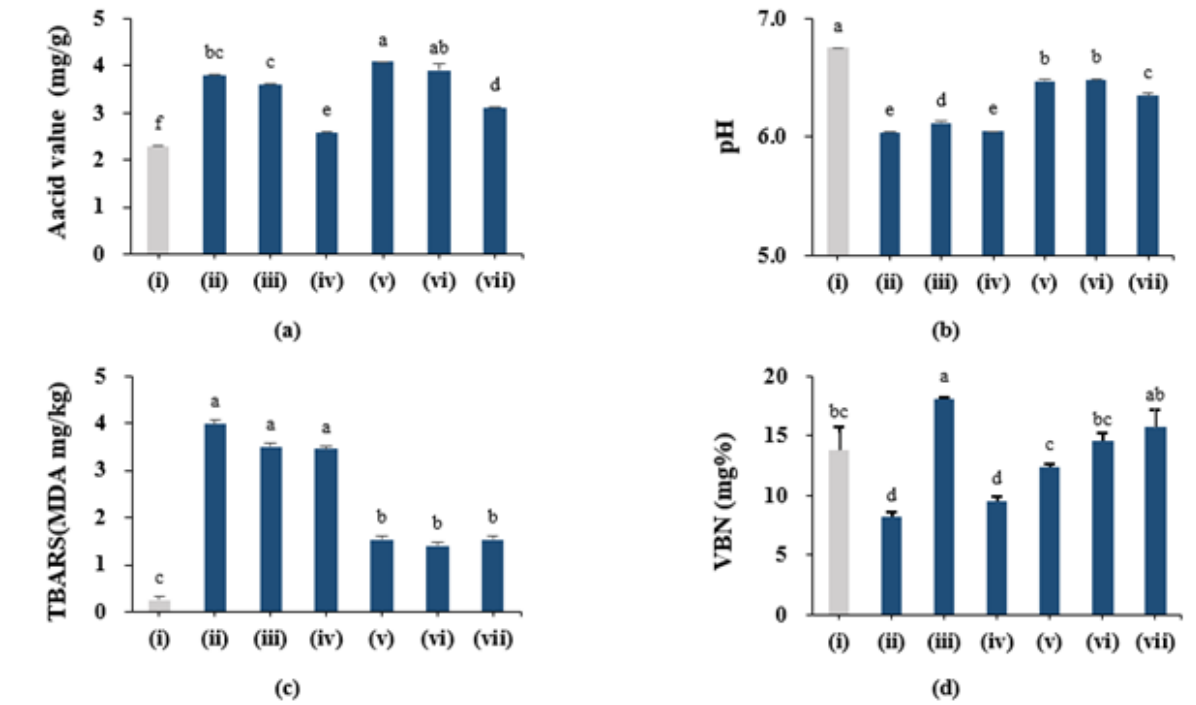
Figure 3. The chemical quality parameters (( a ), acid value; ( b ), pH; ( c ), TBARS; ( d ), VBN) of the drone pupae powders depending on the pretreatment conditions. (i) The control drone pupae; (ii) UHD;